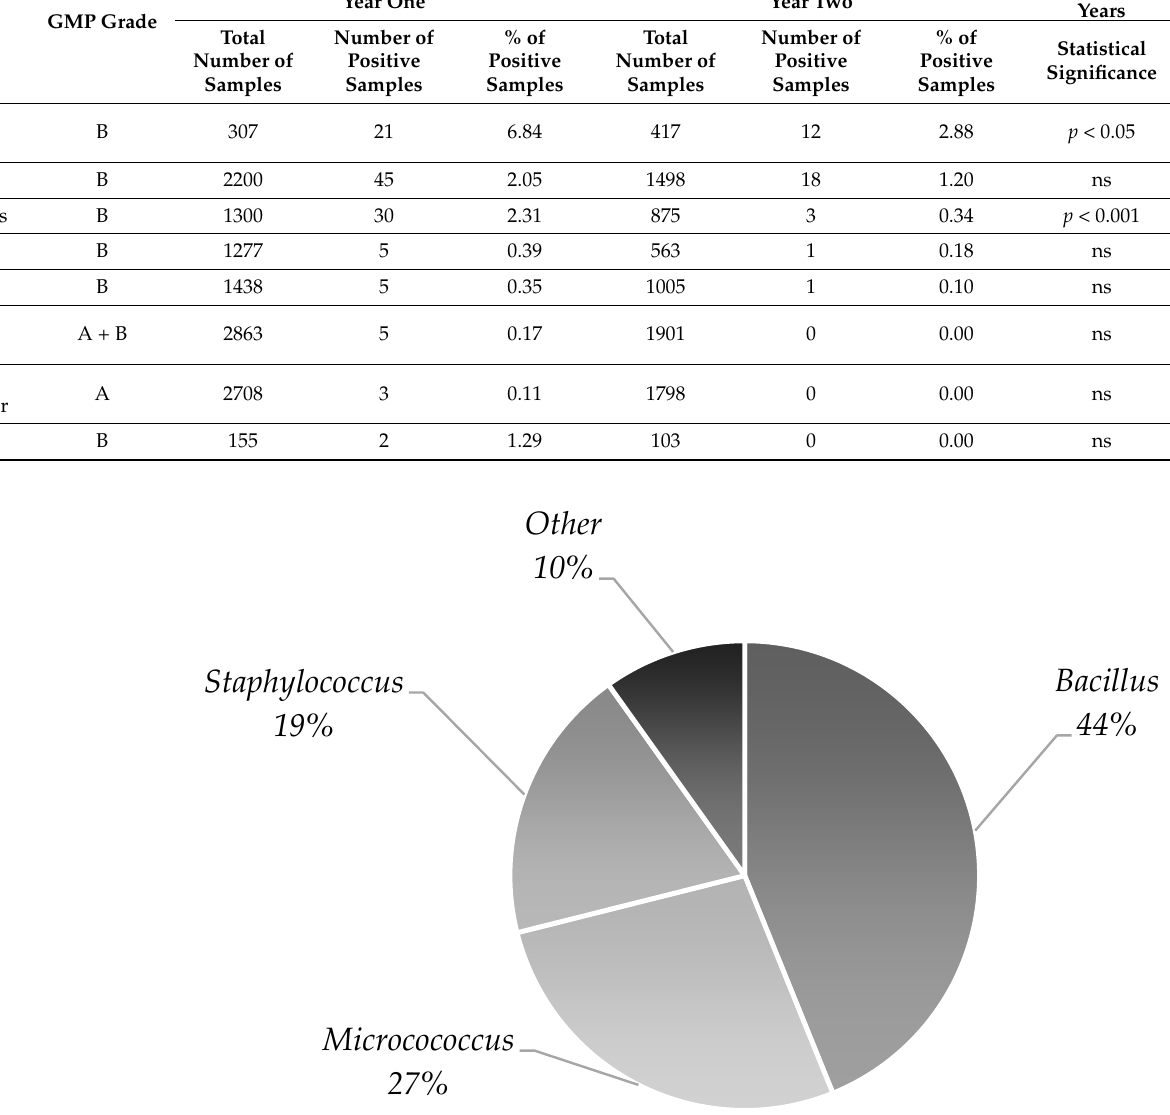
Figure 4. Cleanroom microbiota identified during the two-year clinical trial presented as % of isolated genera out of all identified